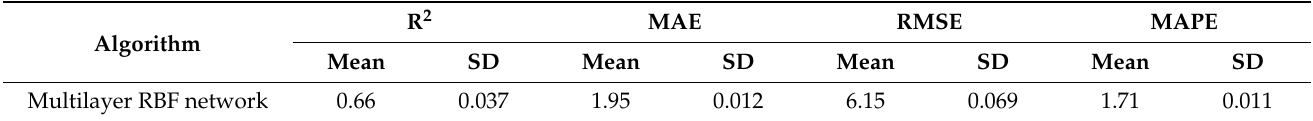
Table 3. Results of 10-fold cross-validation. SD ( × 10 − 4 ) is the standard deviation.